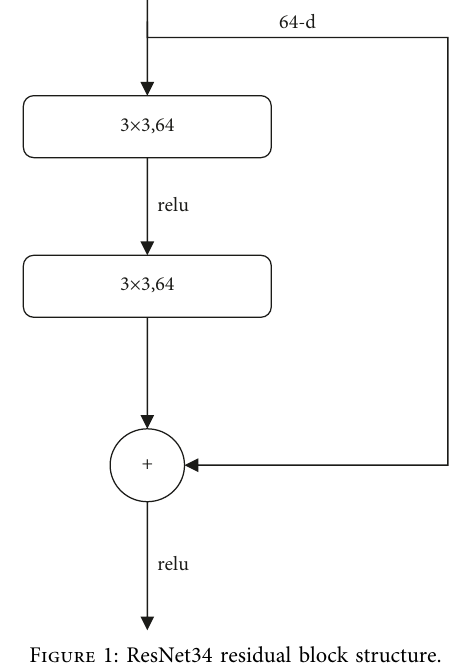
Figure 1: ResNet34 residual block structure.